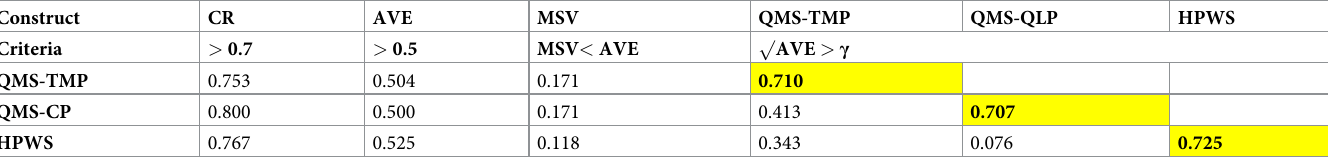
Table 4. Convergent & discriminant validity and construct reliability results of second order